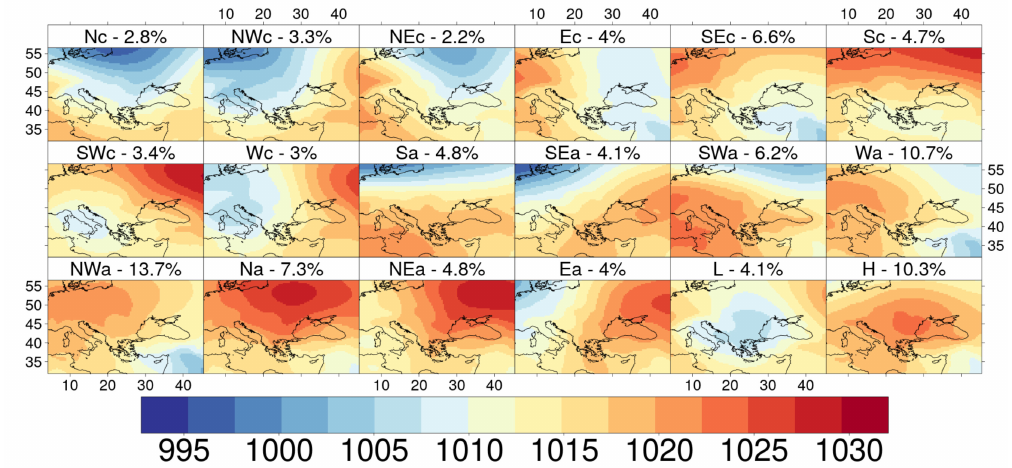
Figure 2. Types of atmospheric circulation according to GWT classification for the region of Romania based on Sea Level Pressure (hPa); cyclonic (c) and anticyclonic (a) subtypes are separated based on the cardinal position of the pressure centers towards the center of the domain (N-north, NE-north-east, E-east, SE-south-east, S-south, SW-south-west, W-west, NW-north-west) next to cyclonic (L) and anticyclonic (H) types when these pressure centers are located over the territory of